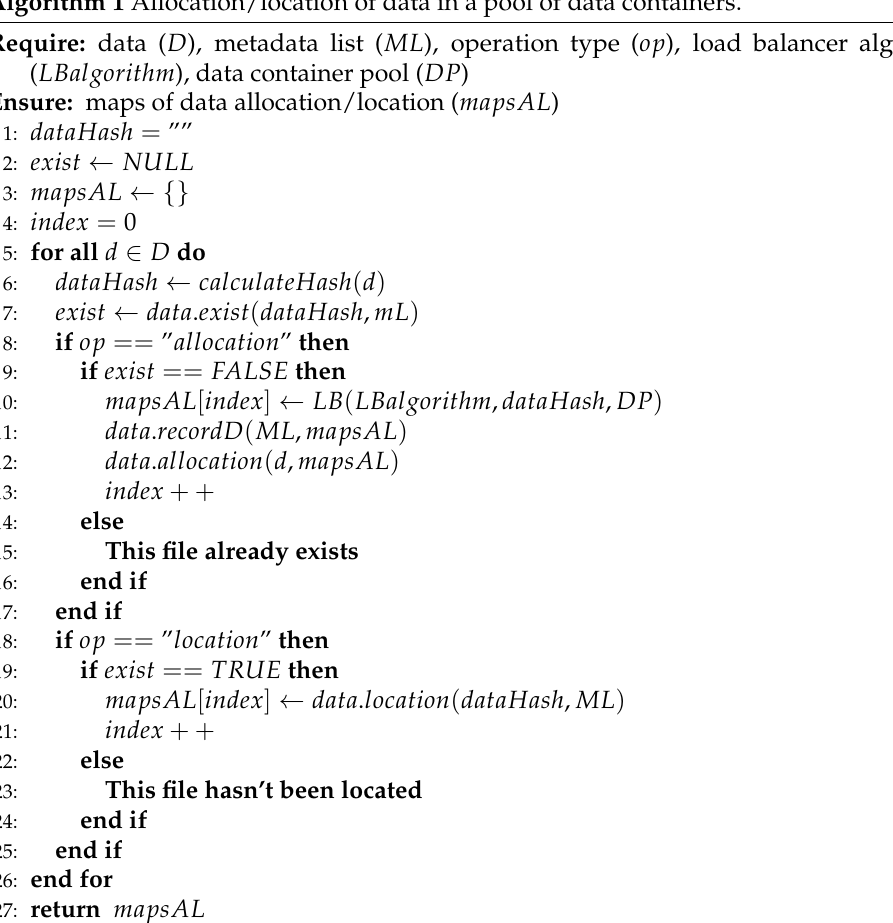
Algorithm 1 Allocation/location of data in a pool of data